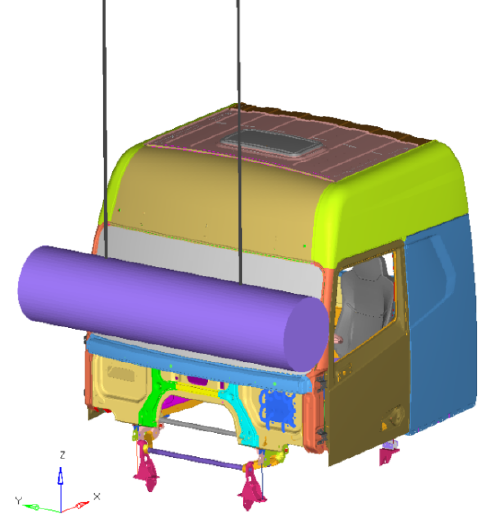
Figure 10. Finite element model of the truck cab.